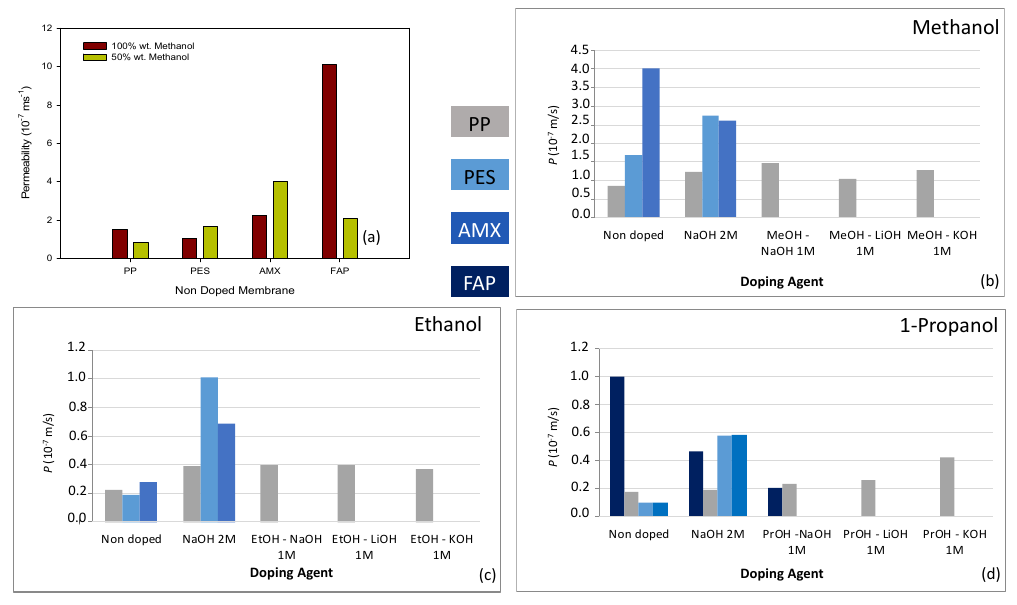
Figure 4. Values of the alcohol permeability estimated for all the membranes investigated in this work.